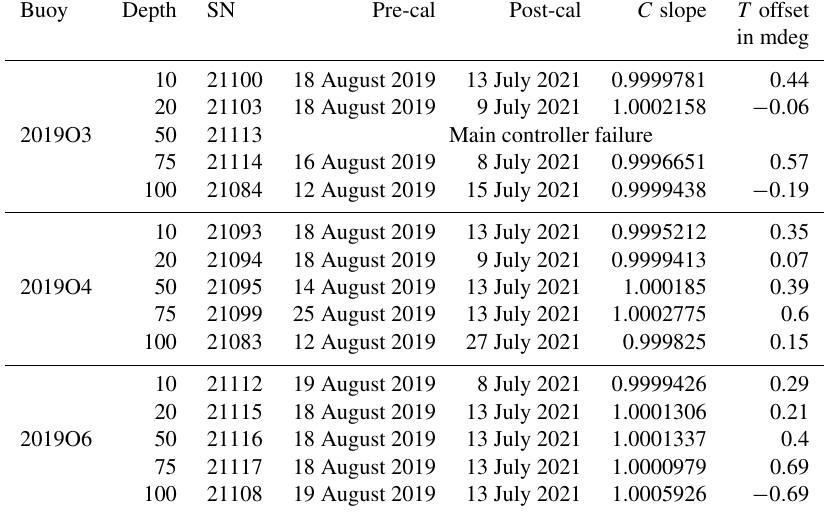
Table 4. Temperature offset and conductivity drift from post-deployment calibration. Pressure (not shown) did not drift at all. This infor- mation is provided here for reference. Corrections have not been applied to the data (see text). Note: SN is the serial number, Pre-cal is the pre-calibration date, and Post-cal is the post-calibration date. Buoy Depth SN Pre-cal